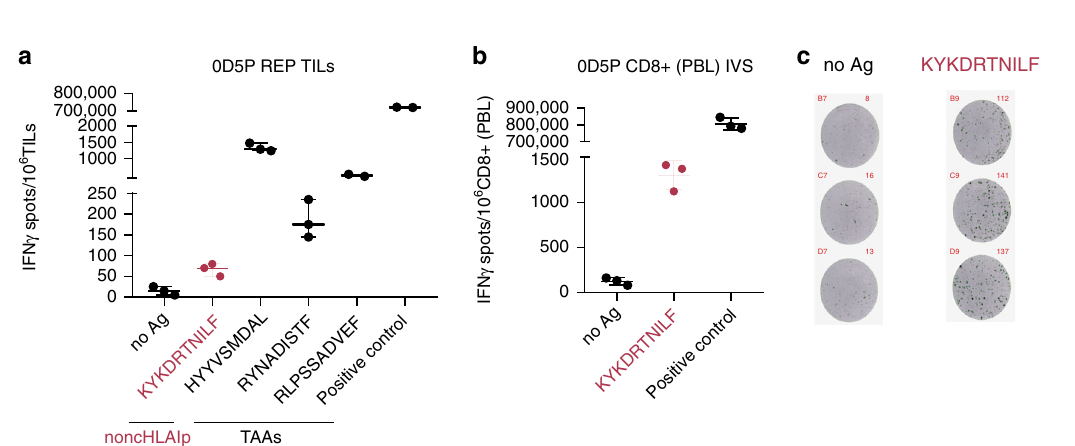
Fig. 9 Non-canonical ABCB5 peptide induced an IFN γ response. a Reactivity was measured in melanoma 0D5P by the IFN γ ELISpot assay using autologous REP TILs. Representative example of three TAAs from TYR and TYRP1 and one non-canonical dORF-derived HLAIp from ABCB5 (written in red) that induced an IFN γ response. b In addition, a representative example of CD8 + T lymphocytes from PBLs is shown when re-challenged with autologous CD4 + blasts together with 1 μ M of the non-canonical ABCB5 HLAIp. (No Ag: no peptide, positive control: 1x cell stimulation cocktail). c Representative images of the IFN γ ELISpot response against the non-canonical ABCB5 peptide. In a and b , T cell reactivity for every peptide was validated by ≥ 2 independent experiments. Please refer to the Methods section for boxplot parameters. Source data are provided as a Source Data fi